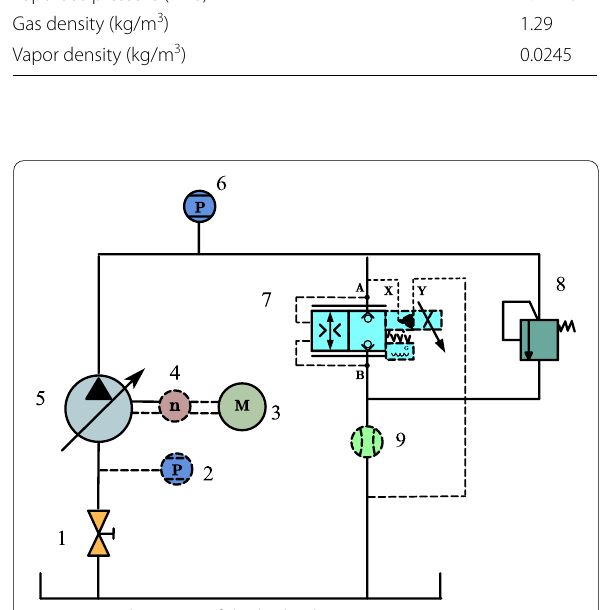
Figure 3 Schematics of the hydraulic circuit